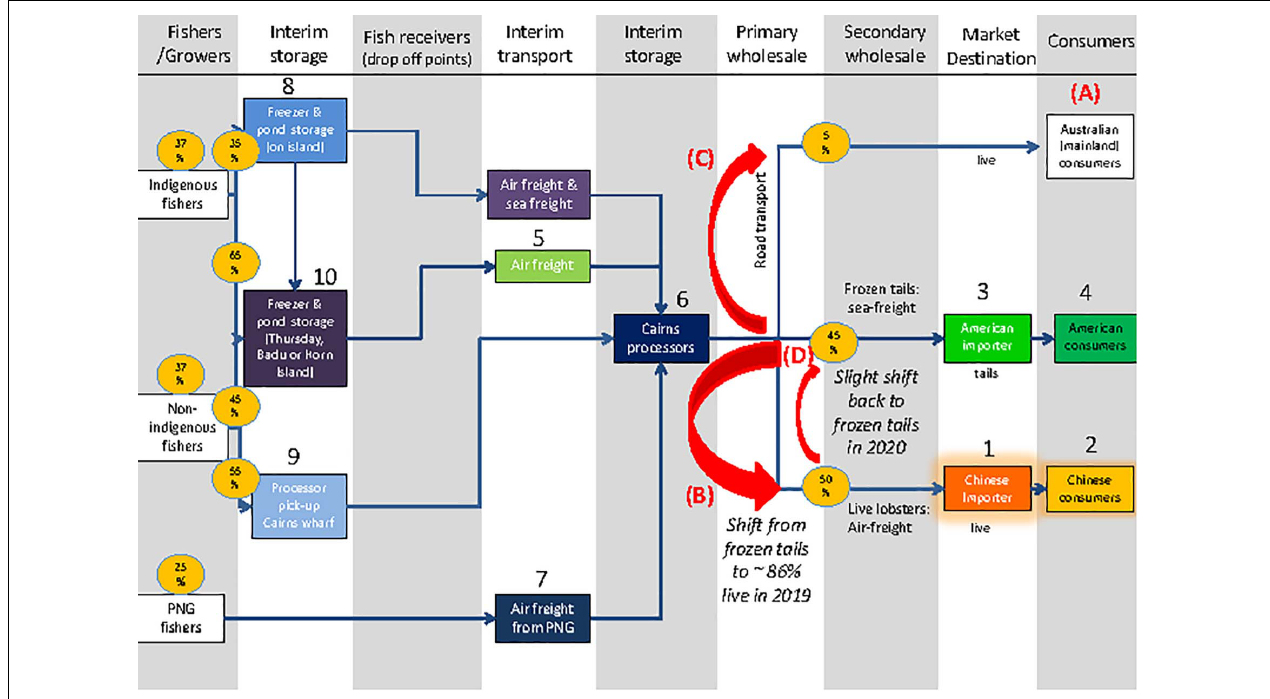
FIGURE 2 | Torres Strait tropical lobster 2012 supply chain schematic modified from Plagányi et al. (2014), highlighting with a red arrow the post-2012 shift to exporting almost all live lobsters, and a small reversal of that market shift during 2020. The large numbers next to nodes show the ranking of the top ten critical elements in the supply chain (orange highlights the most critical node) based on applying the Supply Chain Index method of Plagányi et al. (2014). The figure shows the 2012 base configuration (A) as well as variants (B) shift to more live; (C) increase domestic market and (D) greater domestic market and product split between live and tails, as discussed in the